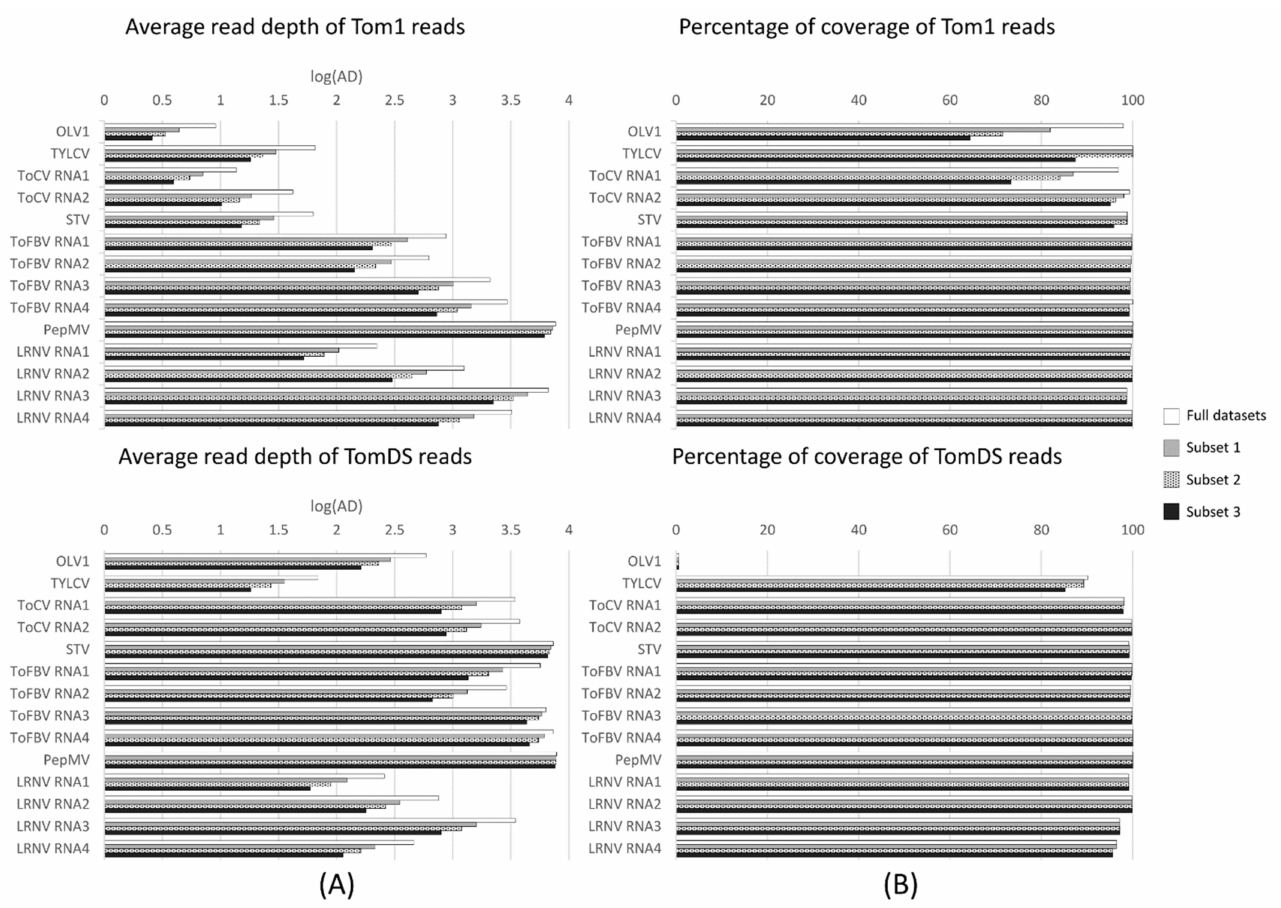
Figure 3. Comparison of average read depth and percentage of viral genomes covered by reads in Tom1 and TomDS. ( A ) Bar plots showing the logarithm of the average read depth for each viral genome in Tom1 ( upper ) and TomDS ( bottom ). ( B ) Bar plots showing the percentage of viral genomes covered by reads in Tom1 ( upper ) and TomDS ( bottom ). Full datasets: white bars; Subset 1: gray bars; Subset 2: dotted bars; Subset 3: black